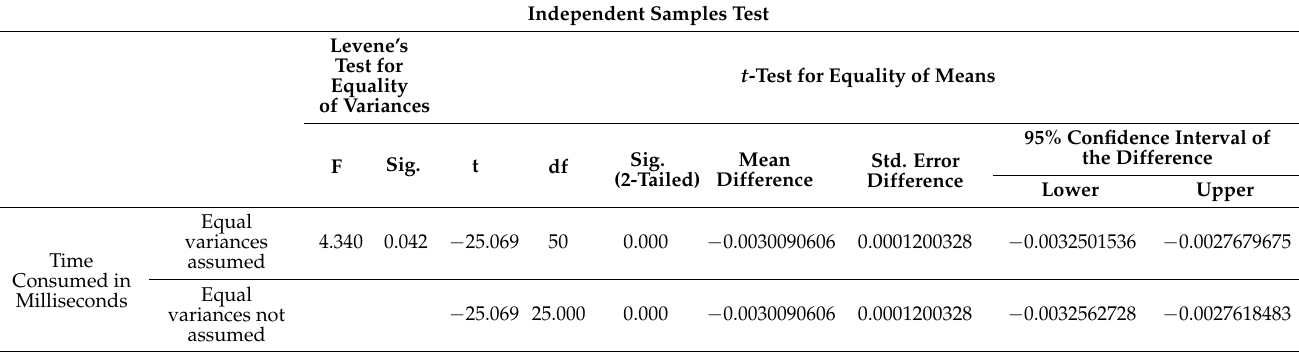
Table 3. t -Test Results and Statistical Analysis of Single and